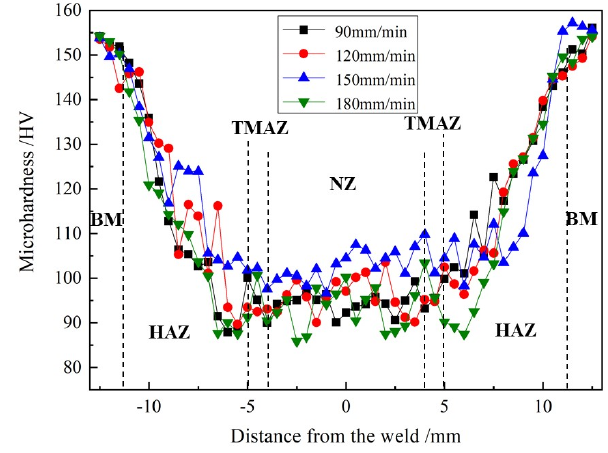
Figure 6. Microhardness of different FSW joints.